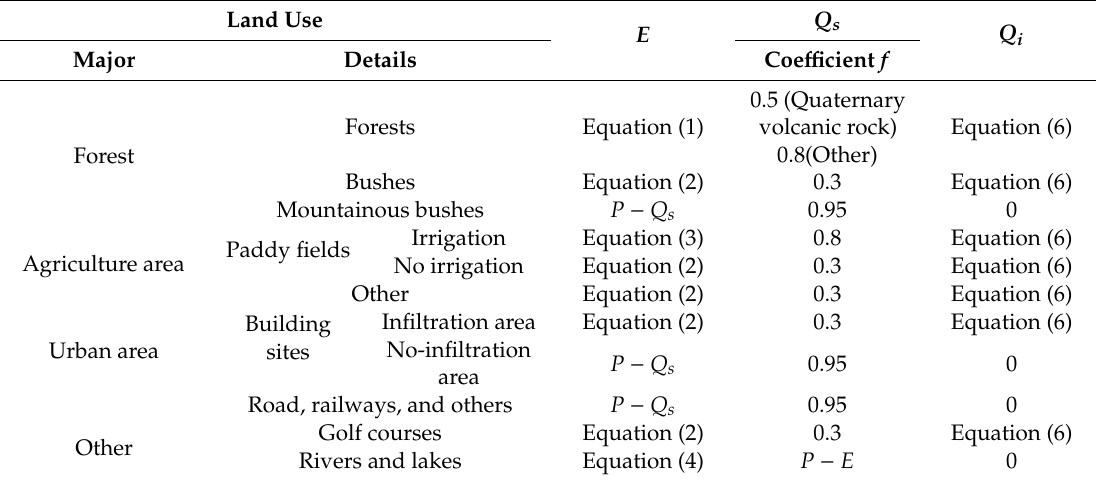
Table 1. Evaluation for evapotranspiration, E , surface runo ff , Q s , and underground infiltration, Q i , in the present